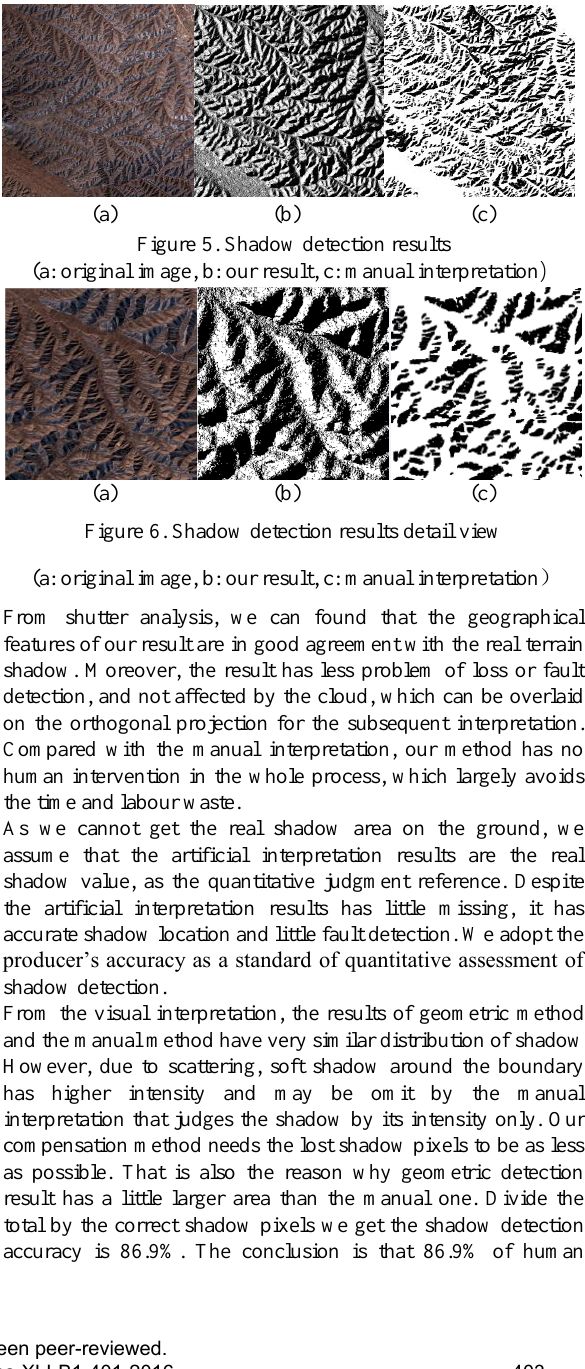
Figure 5. Shadow detection results